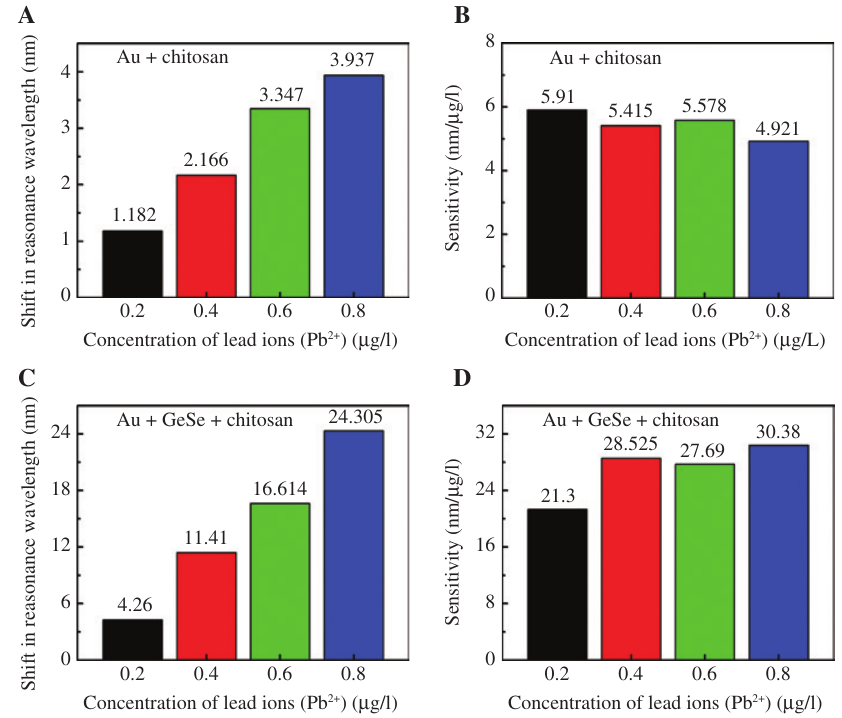
Figure 9: A comparison diagram of sensor performance. (A) The resonance wavelength shifts and (B) detection sensitivity of the Au-chitosan based sensor with Pb 2 + concentration changing from 0.20 μ g/l to 0.80 μ g/l. (C) The resonance wavelength shifts and (D) sensitivity of the Au-GeSe-chitosan based sensor with Pb 2 + concentration changing from 0.20 μ g/l to 0.80 μ g/l.